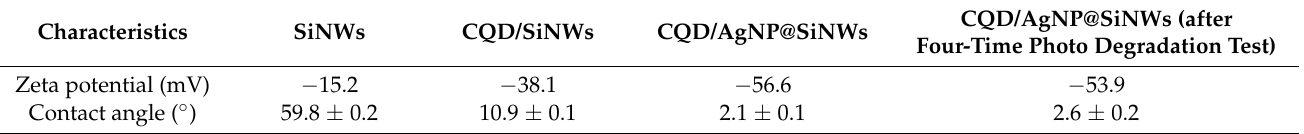
Figure 6. Contact-angle photographs of three various samples.